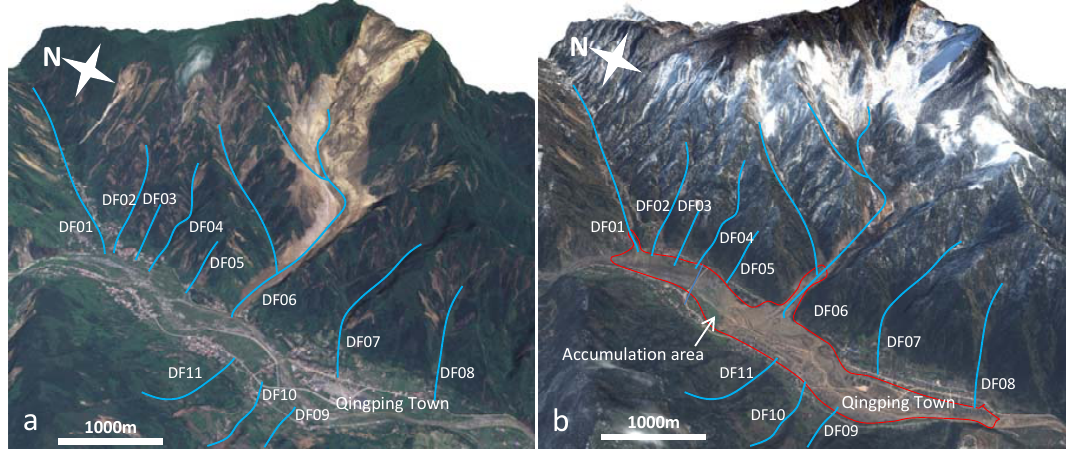
Fig. 3. Pre-seismic and post-seismic aerial photographs of the 13 August 2010 debris flow events near to Qingping Town ( a : taken on Fig. 3. Pre-Seismic and post-Seismic aerial photographs images of the August 13, 18 May 2008; b : taken on 13 December 2010), DF is the abbreviations of Debris Flow 2010 debris flow event Near Qingping Town (a: taken on May 18,2008; b: taken on December 13, 2010), DF is the abbreviations of Debris Flow gulley.